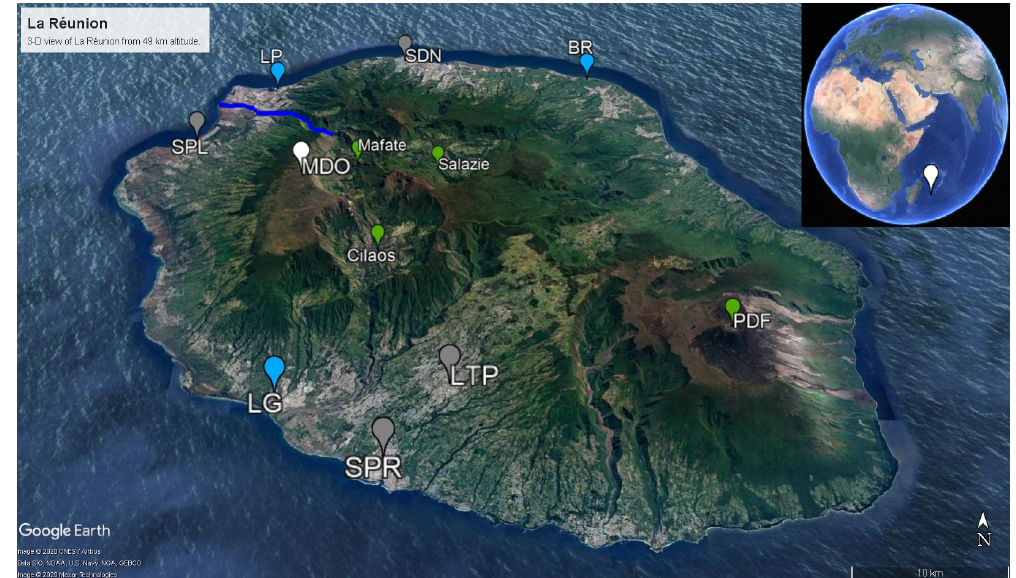
Figure 1. La Réunion, viewed from 49km height. The Maïdo observatory (MDO) is indicated in white. Cities with population over 50000 habitants – i.e., Saint-Denis (SDN), Saint-Paul (SPL), Le Tampon (LTP), and Saint-Pierre (SPR) – are shown in gray. The largest industrial sites – Le Port (LP), Bois-Rouge (BR), and Le Gol (LG) – are indicated in blue. Geological landmarks – Calderas Mafate, Salazie, and Cilaos as well as the shield volcano Piton de la Fournaise (PDF) – are in green. The river Rivière des Galets between Mafate and Le Port is indicated as a dark blue line. The image was generated with Google Earth Pro, data SOI, NOAA, U.S. Navy, GA, GEBCO. © 2020 CNES/Airbus, © 2020 Maxar